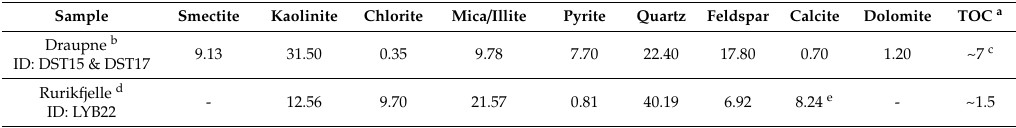
Table 1. Mineral composition of Draupne and Rurikfjellet shales in percentage. The sum of percentage of minerals for each sample in this table is greater than 100% which may be due to a poor detection and overlap between some of the clay minerals characterized by XRD.